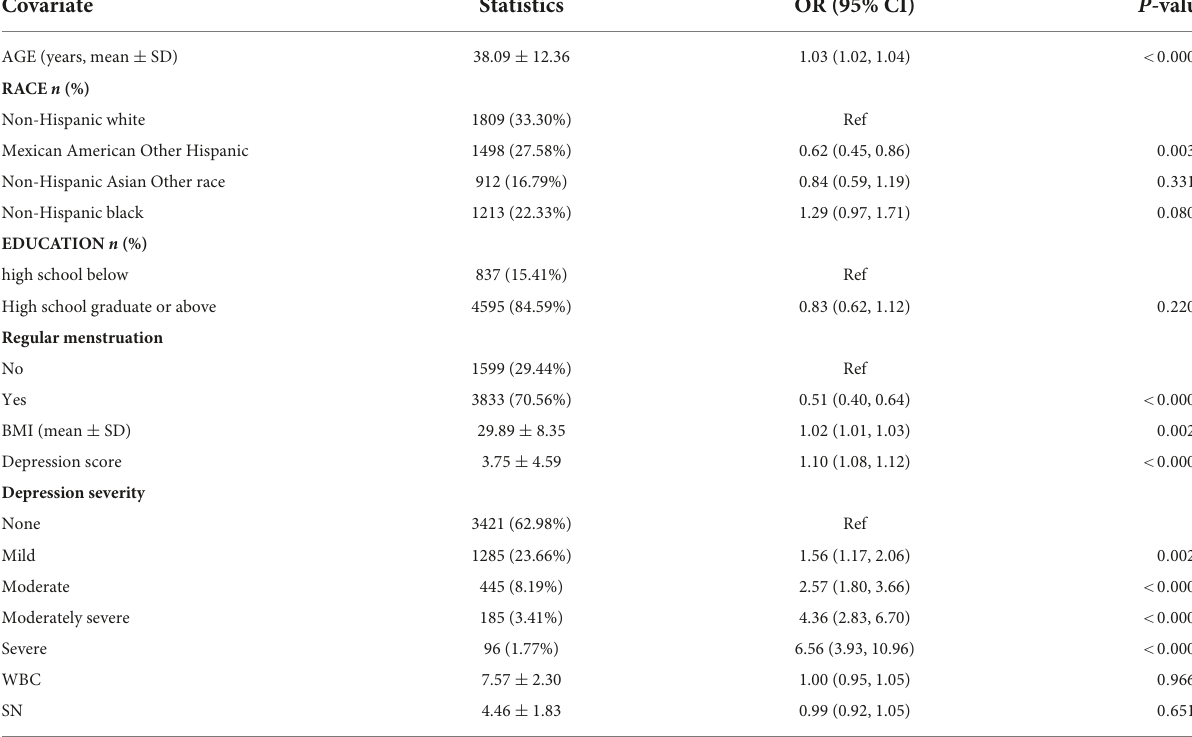
TABLE 2 Univariate analysis for prevalence of pelvic inflammatory diseases.